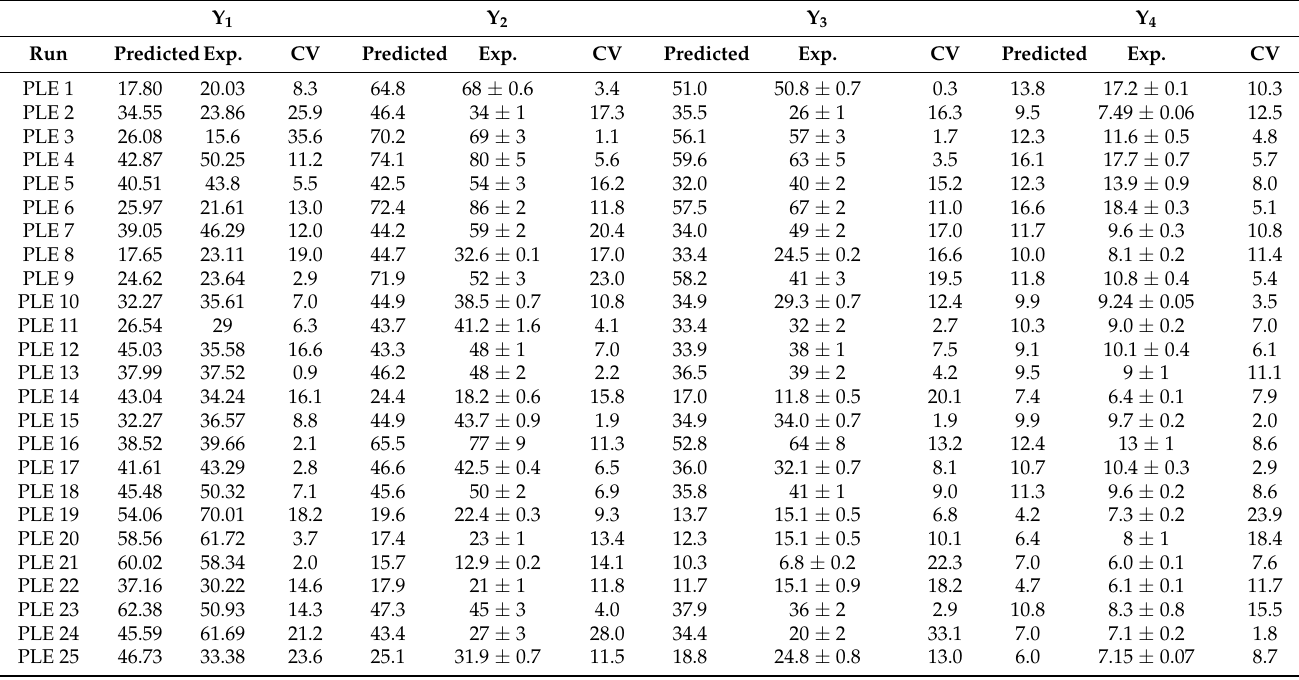
Table 3. Comparison between experimental results and predicted values for PLE.